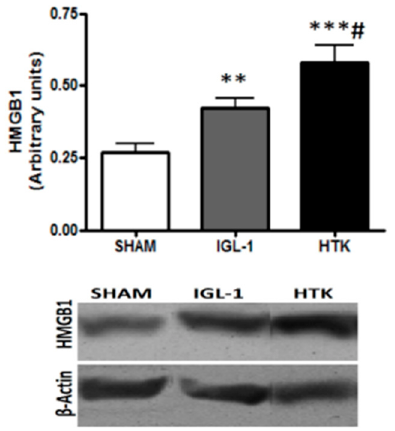
Figure 7. Changes in HMGB1 expression in controls and livers preserved in IGL-1 or HTK. Bar graphs represent the mean ± SD, ** p < 0.005 vs. SHAM, *** p < 0.0005 vs. SHAM, # p < 0.05 vs. IGL-1.